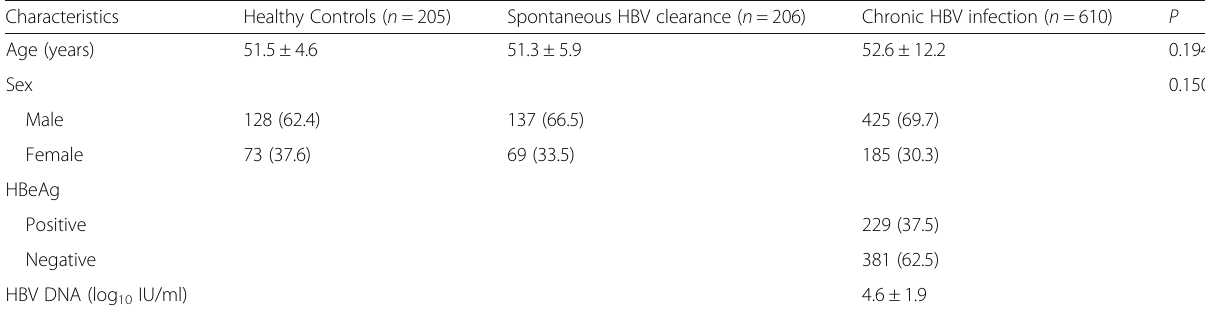
Table 1 Baseline characteristics of subjects in the study